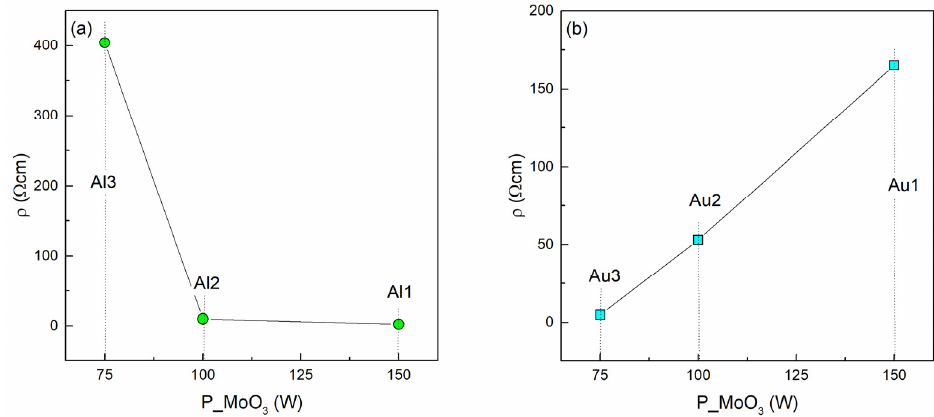
Figure 5. Resistivity as a function of sputtering power of ( a ) Al-based and ( b ) Au-based thin films.